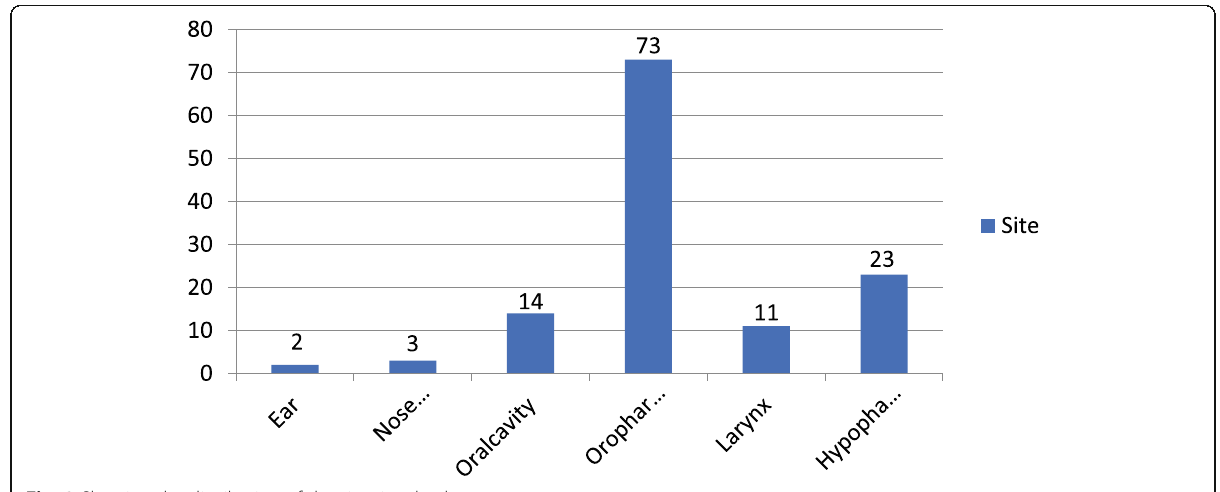
Fig. 3 Showing the distribution of the sites